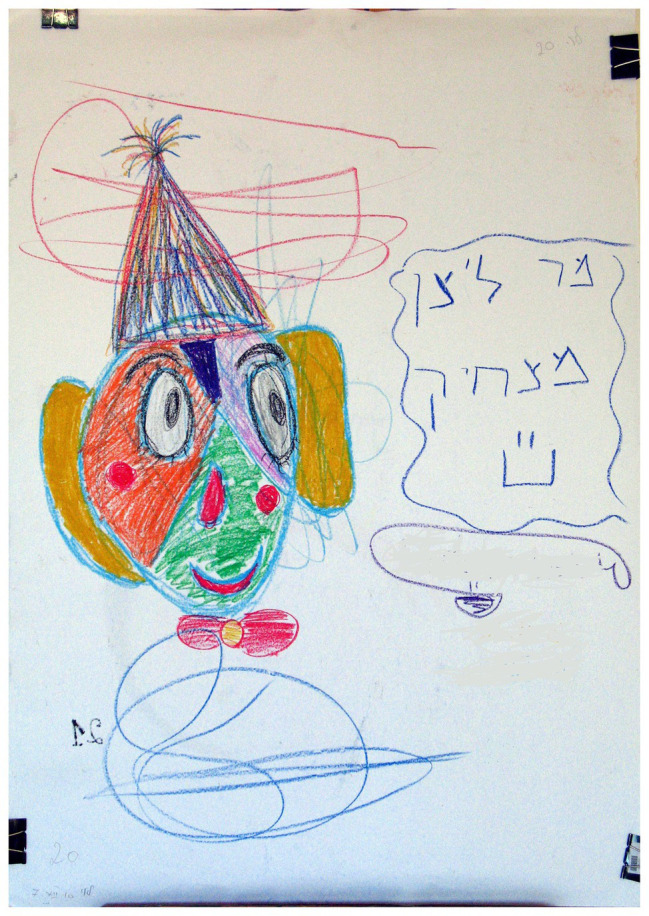
Image of a face.